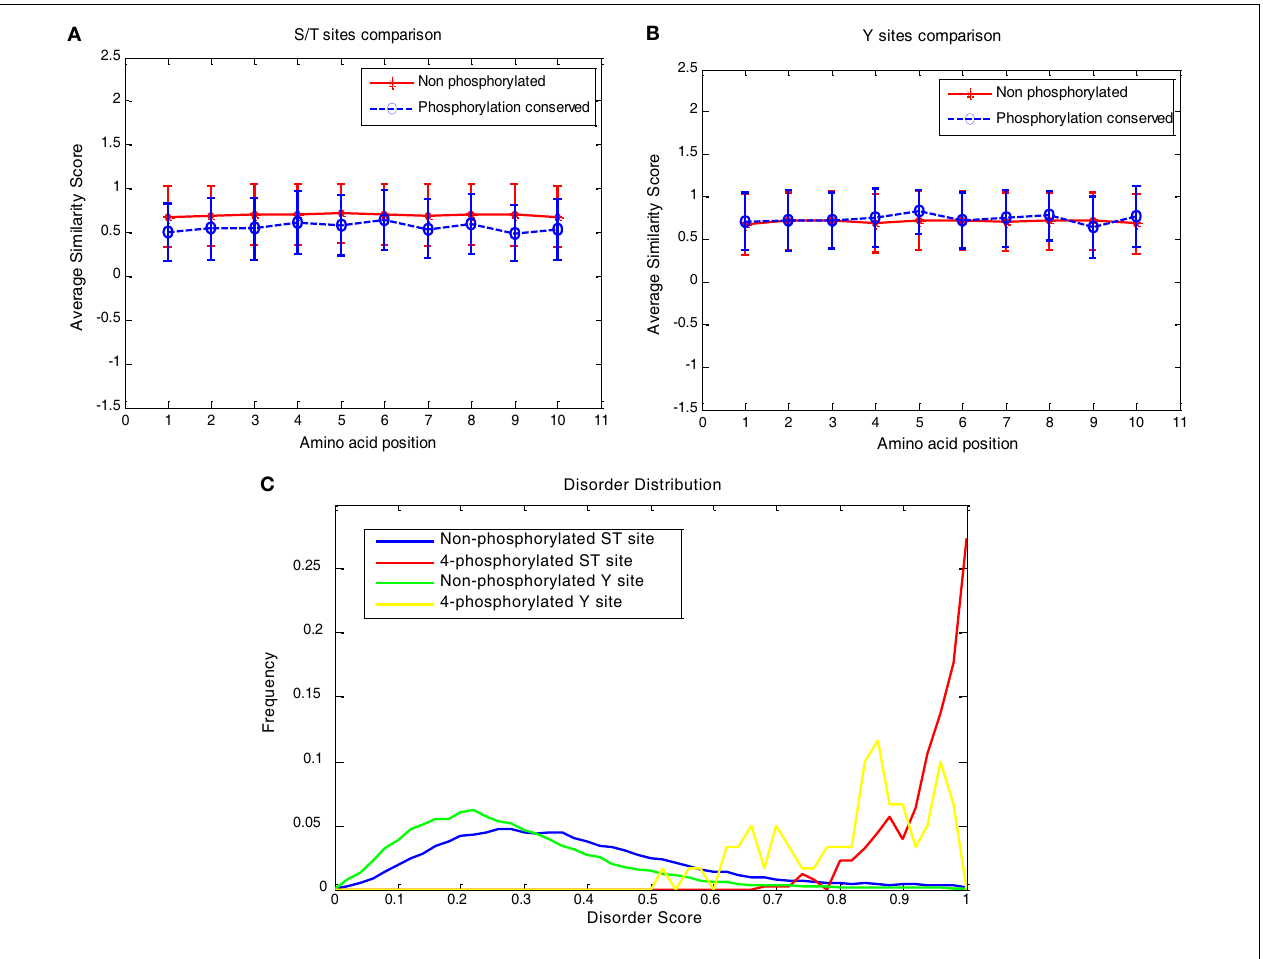
a certain position in the alignment of an orthologous group. (A) For phosphorylated S/T in the center, and (B) for phosphorylatedY in the